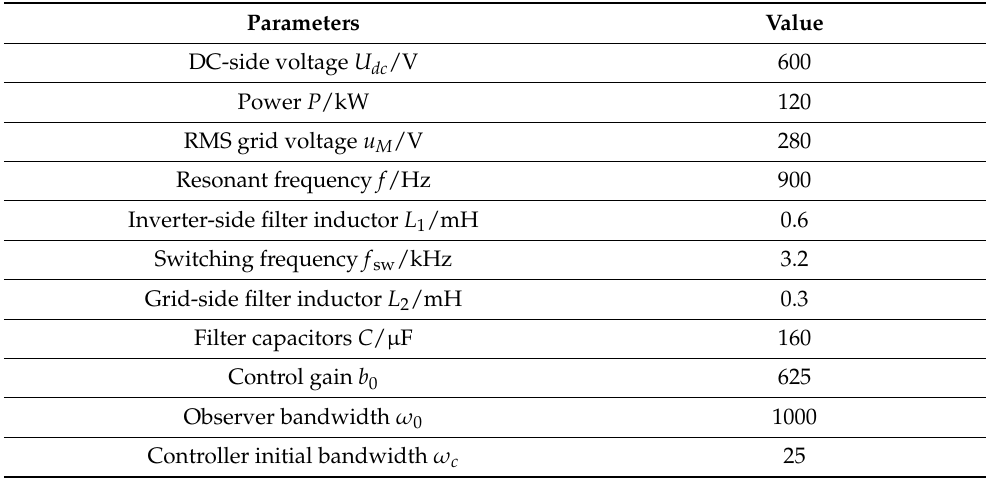
Table 1. Main parameters of system